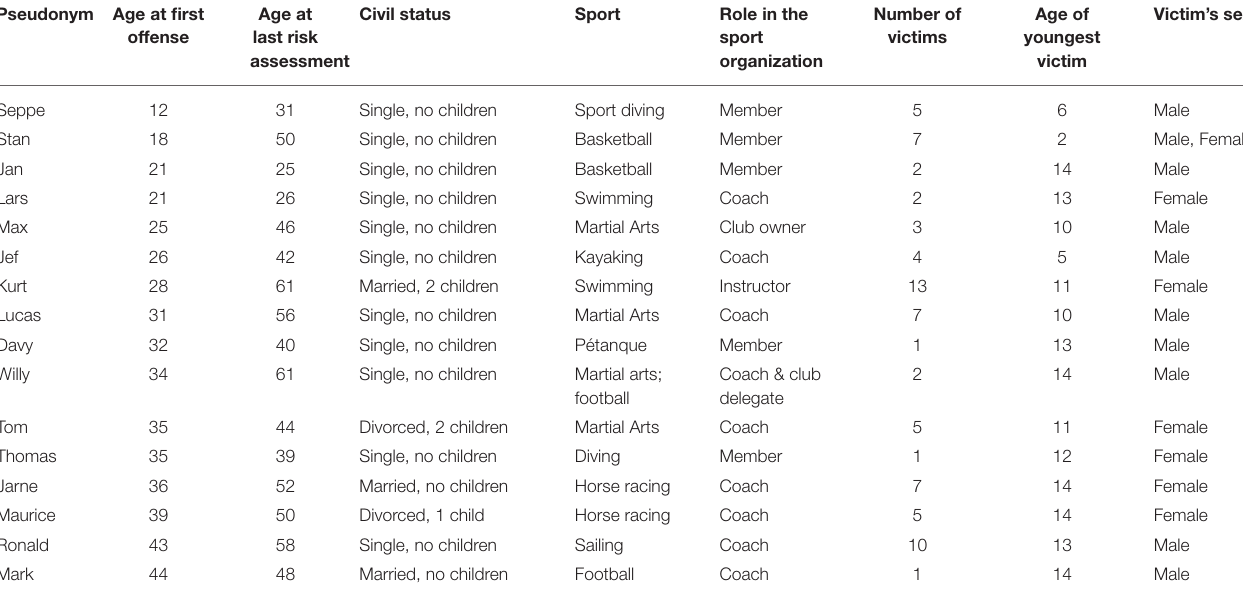
TABLE 1 | Characteristics of PCSO in sport, offenses and victims. Pseudonym Age at first